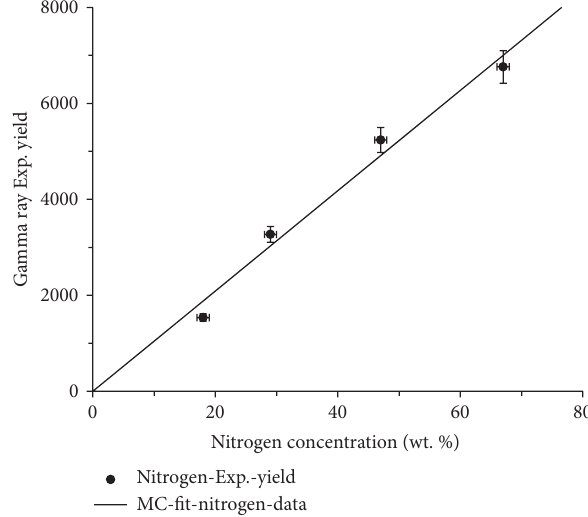
Figure 9: Experimental integrated yields of 2.52 MeV prompt gamma rays from nitrogen plotted as a function of nitrogen con- centration in caffeine, disperse orange, melamine, and urea samples. Line represents the results of the Monte Carlo